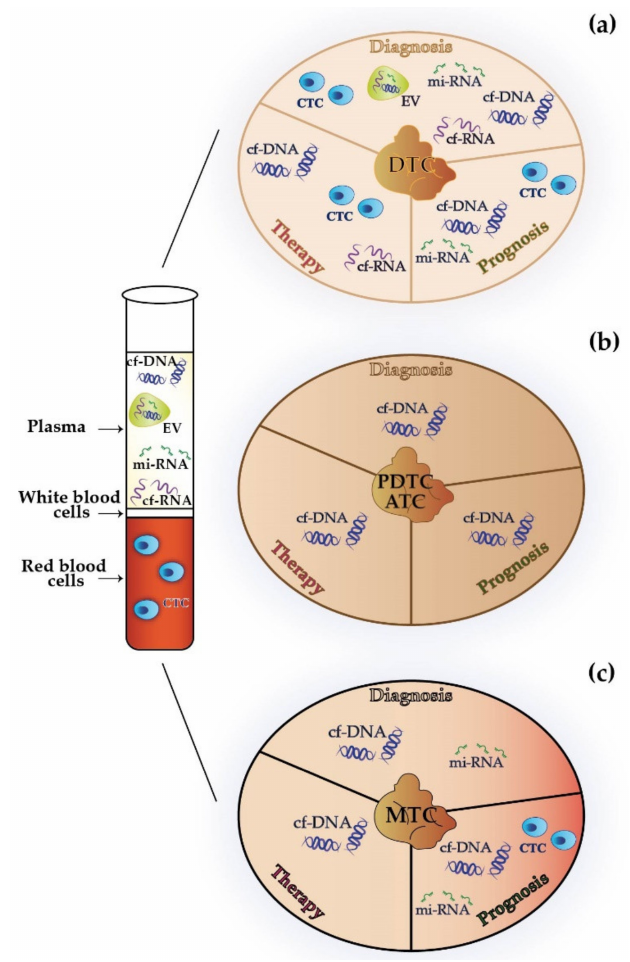
Figure 2. Potential implications of liquid biopsy for the diagnosis, prognostic definition, and therapy of differentiated ( a ), poorly differentiated/anaplastic ( b ), and medullary ( c ) thyroid cancer. cf-DNA, circulating free-DNA; cf-RNA, circulating free-RNA; CTC, circulating tumor cells; DTC, differentiated thyroid cancer; EV, extracellular vesicles; mi-RNA, micro-RNA; MTC, medullary thyroid cancer; PDTC/ATC, poorly differentiated thyroid cancer/anaplastic thyroid